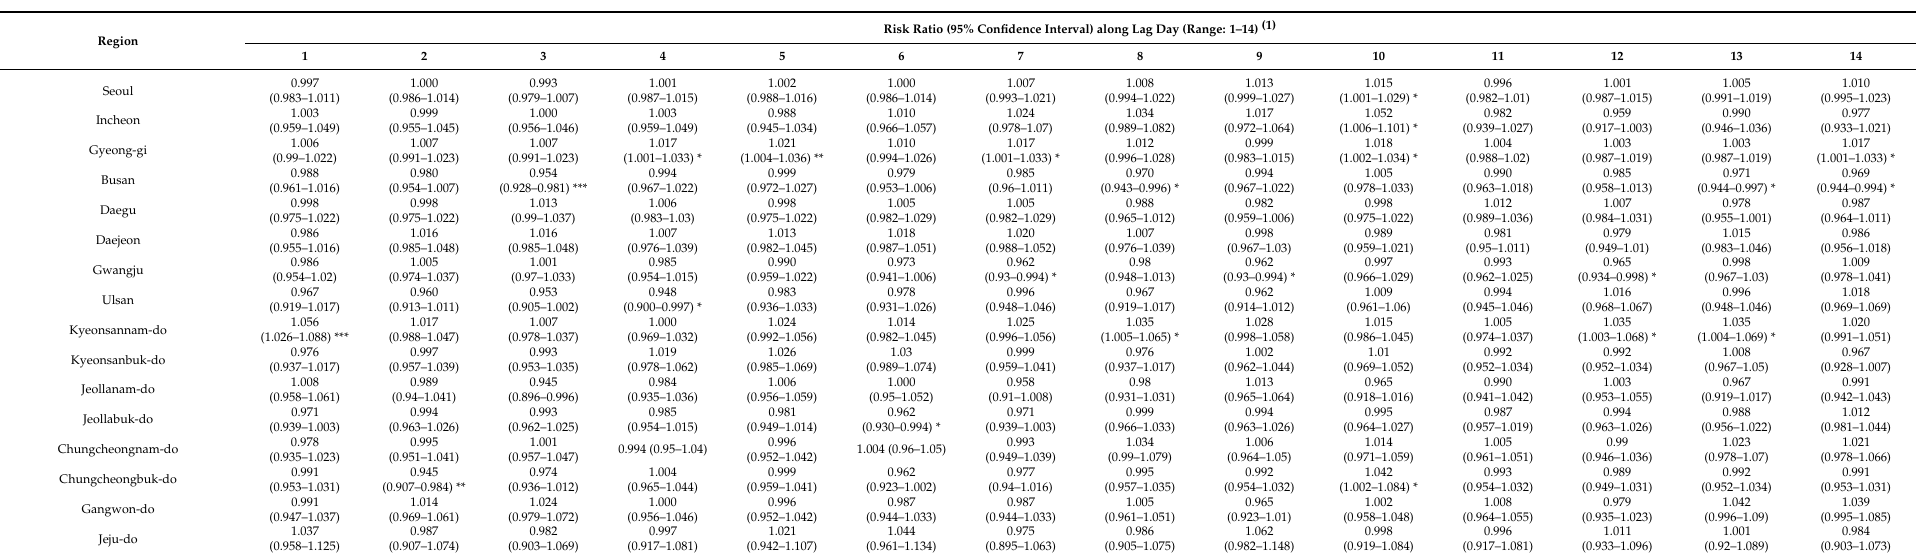
Table 1. Association between DTR and risk of diabetic foot amputation in each